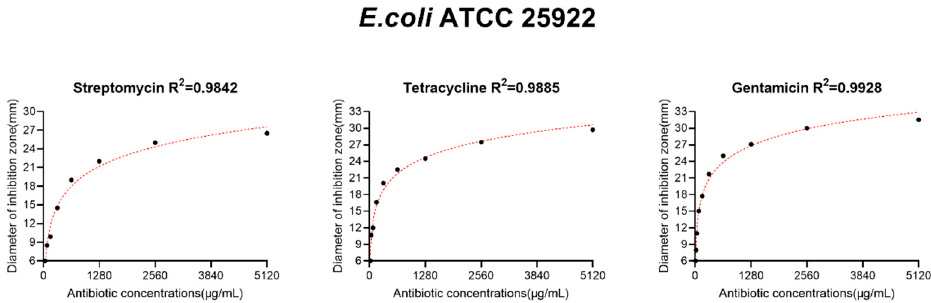
Figure A1. The optimum concentration of antibiotics against E. coli ATCC 25922 (partial).